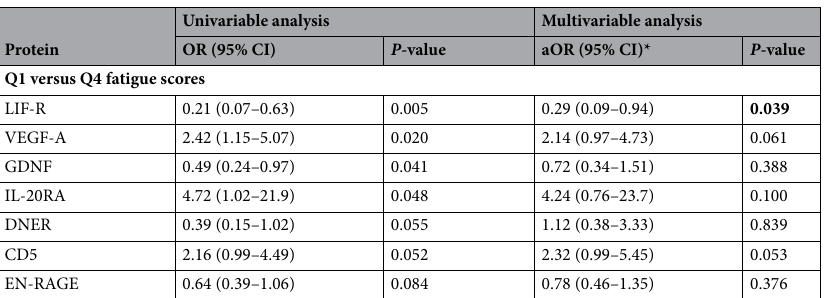
Table 2. Univariable and multivariable logistic regression analyses for associations between plasma proteins and the presence or absence of fatigue in patients with IBD (defined as by median or by the lowest (Q1) versus highest quartile (Q4) of fatigue scores). Data are presented as odds ratios (ORs) with corresponding 95% confidence intervals (CI) and P -values. Bold P -values indicate nominal P -values < 0.05 in multivariable analysis. OR odds ratio, CI confidence interval, aOR adjusted odds ratio. *Significant confounding variables included in multivariable analysis were gender (male/female) and current smoking (no/yes).